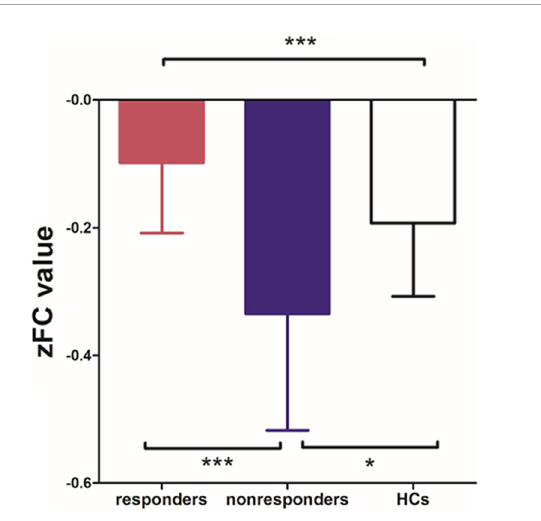
FIGURE1 Differences in DC between responders and non-responders. FIGURE3